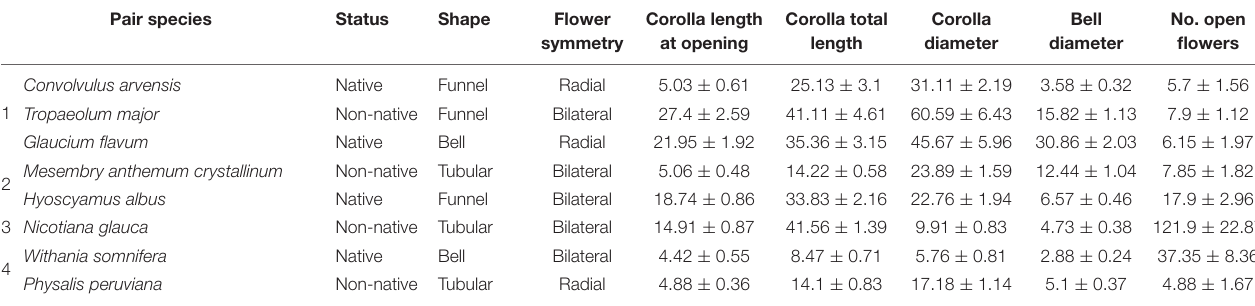
TABLE 1 | Qualitative and quantitative (mean and SD) values of floral traits and number of open flowers of each studied plant species. Pair species Status Shape Flower